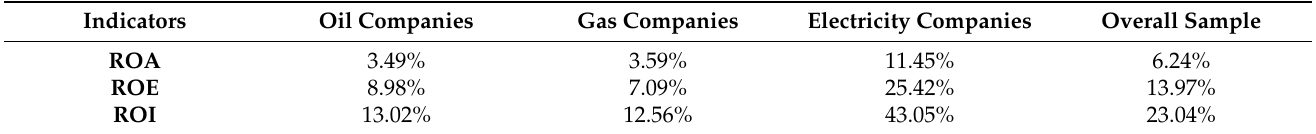
Table 5. The average performance values of energy companies.